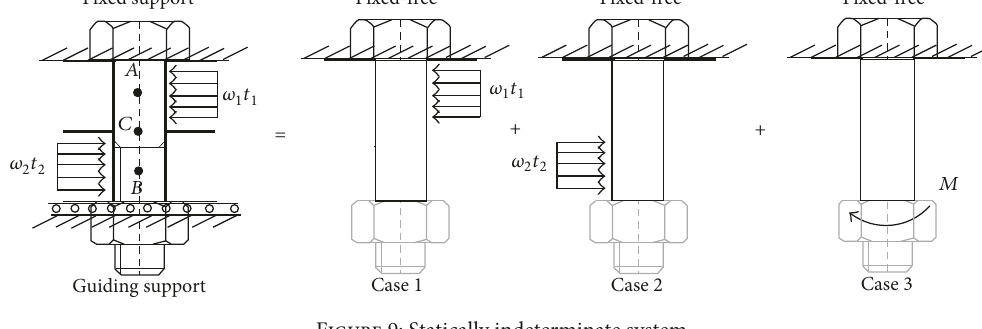
Figure 9: Statically indeterminate system.